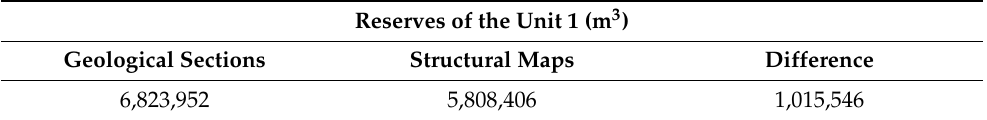
Table 3. Comparison of the reserves of the analysed lithological unit 1 calculated by two